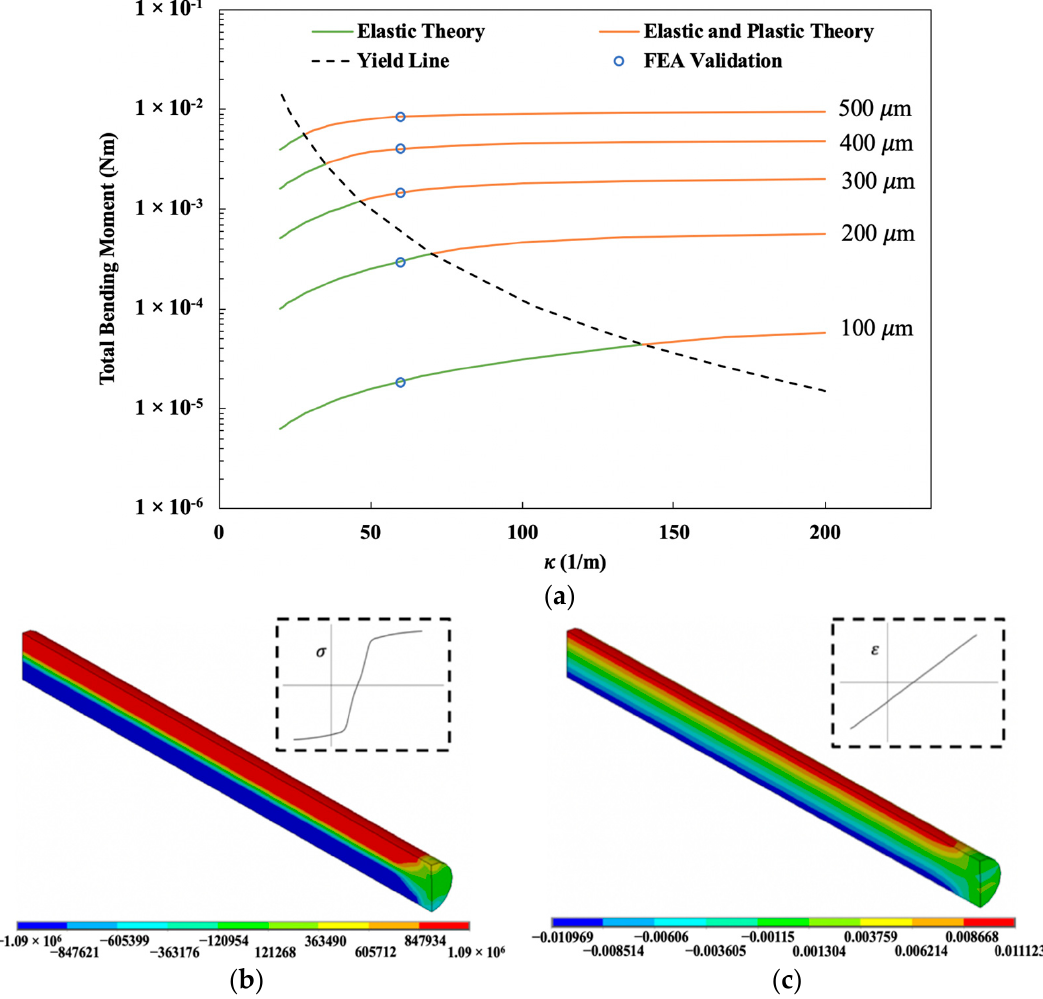
Figure 7. ( a ) Internal moment within an actuator for varying radii of curvature; ( b ) Stress distribution and; ( c ) Strain distribution for 400 μ m diameter wire after bent to a radius of curvature of 1/60 m.